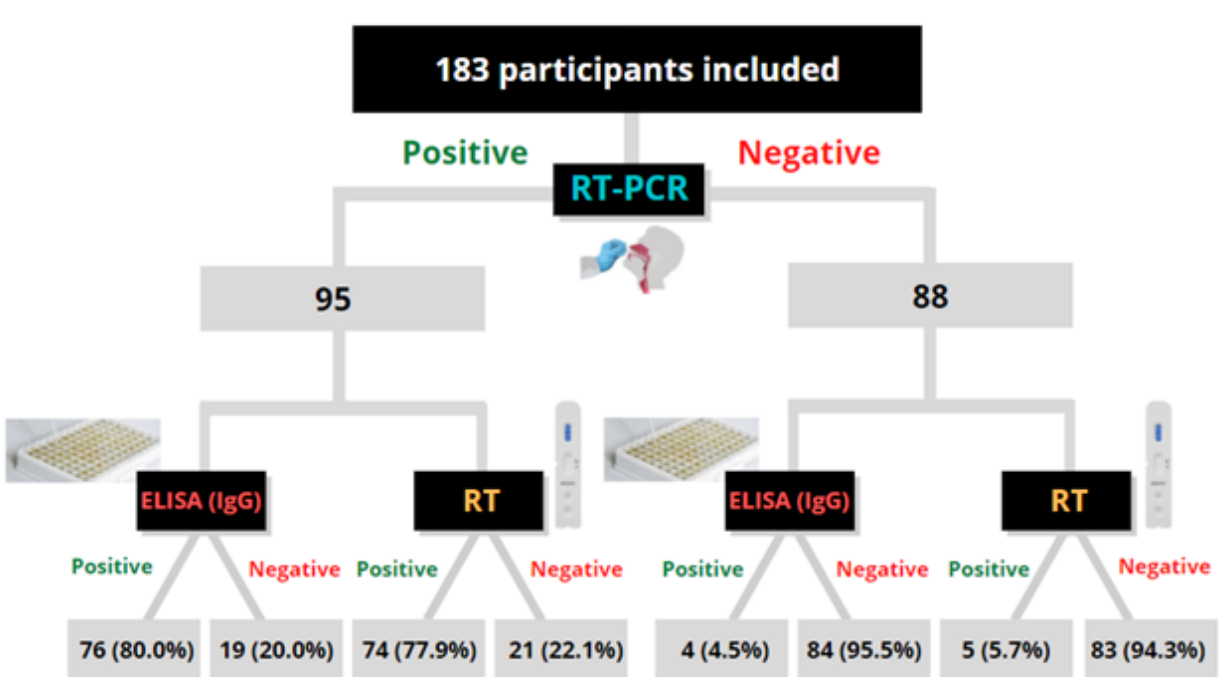
Figure 1. Schematic representation of results obtained from RT-PCR, RT, and ELISA tests.